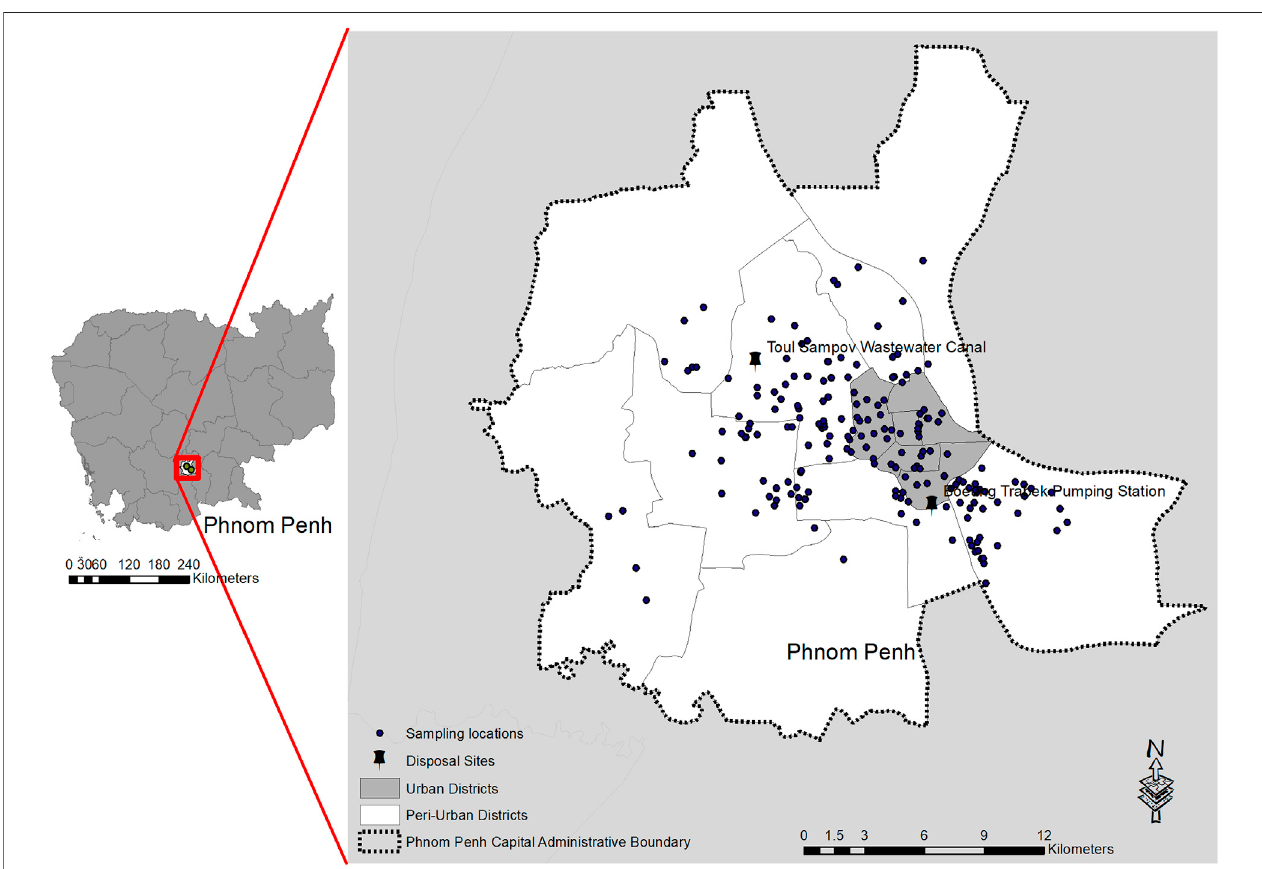
FIGURE1| MapshowingtheareasinPhnomPenhwheredatacollectionwasconducted.Theblackdotsindicatethelocationsofhouseholdssurveyedabouttheir sanitation management practices.